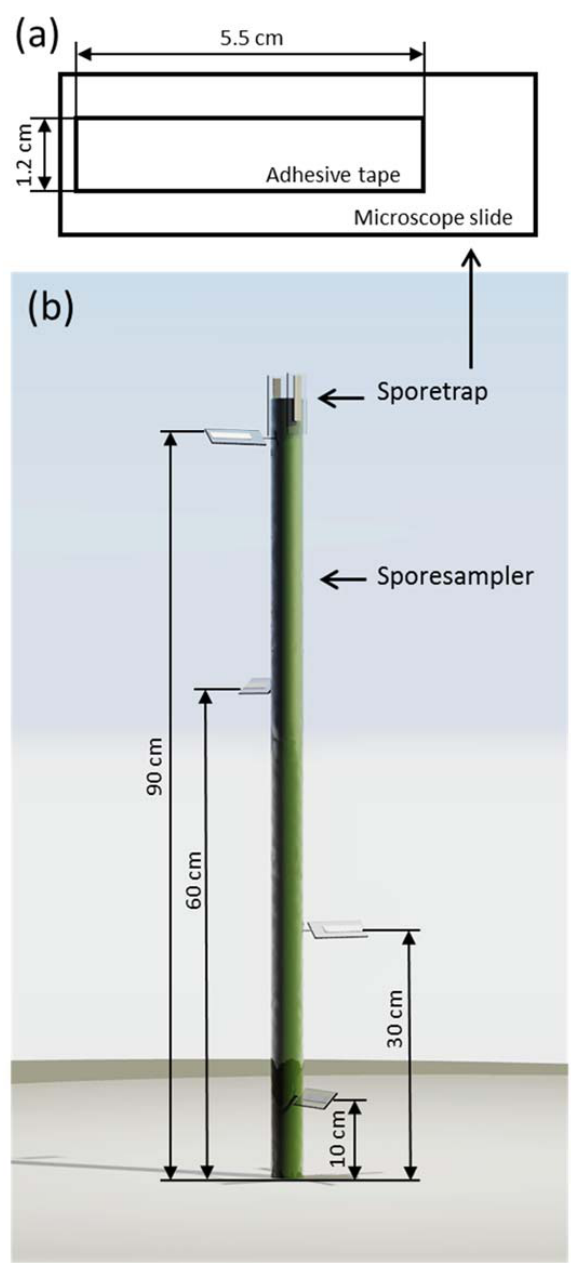
Figure 2. ( a ) The design and dimensions of the spore traps; ( b ) a simplified rendering of the spore sampler, illustrating the placement of the different spore traps.